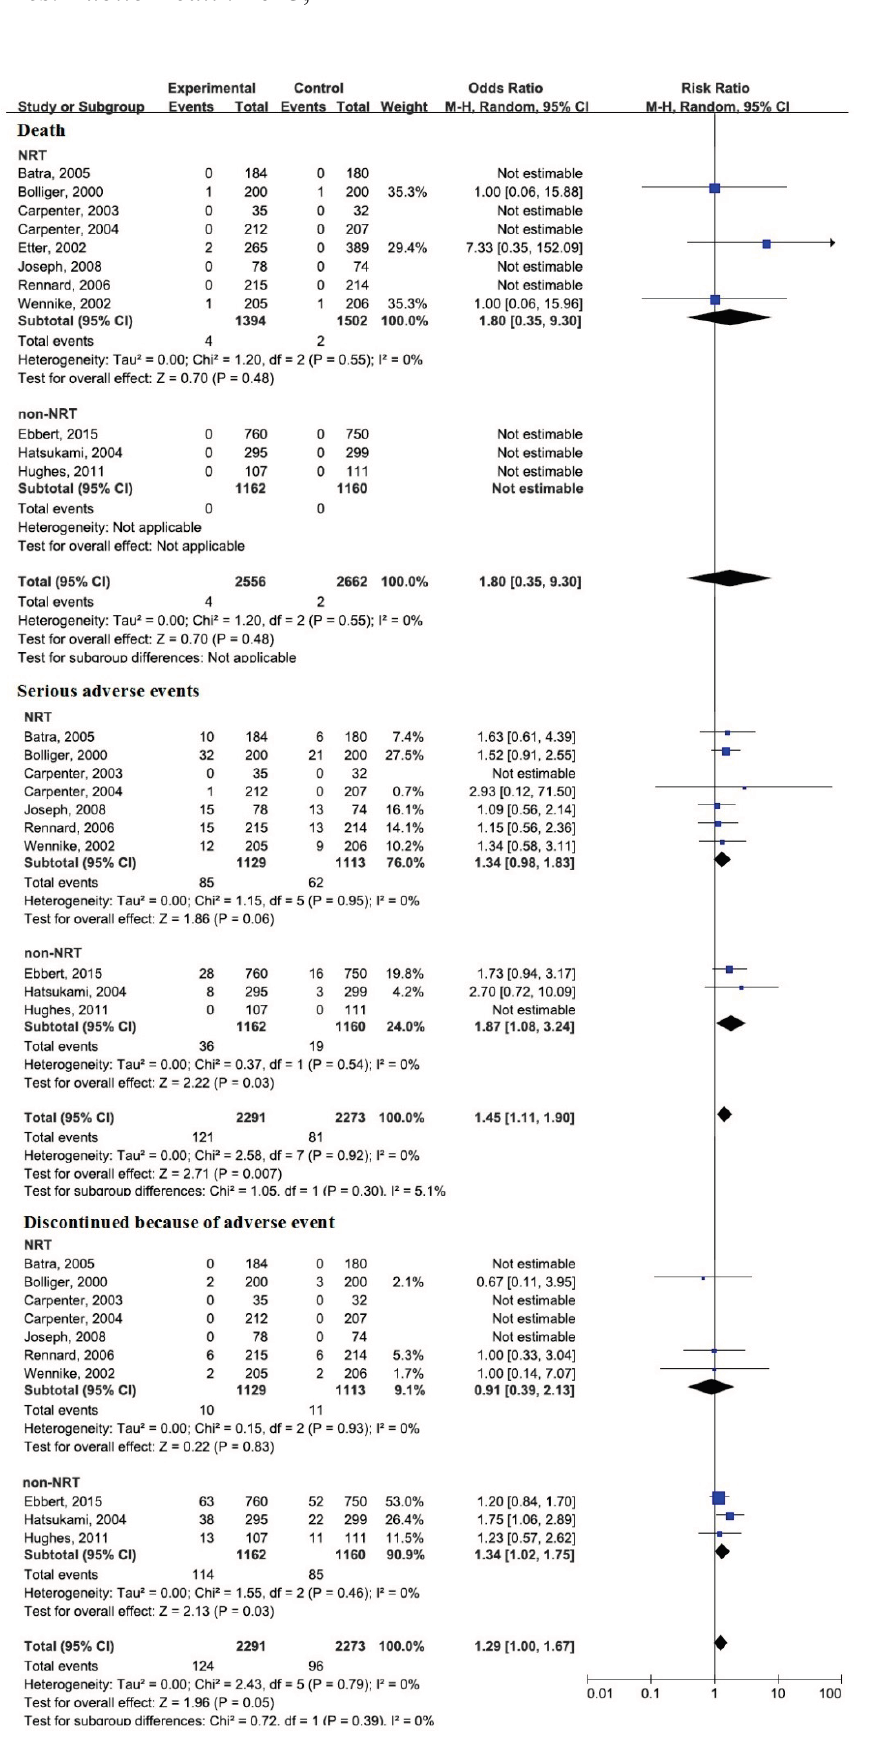
Figure 5. Meta-analysis of the safety